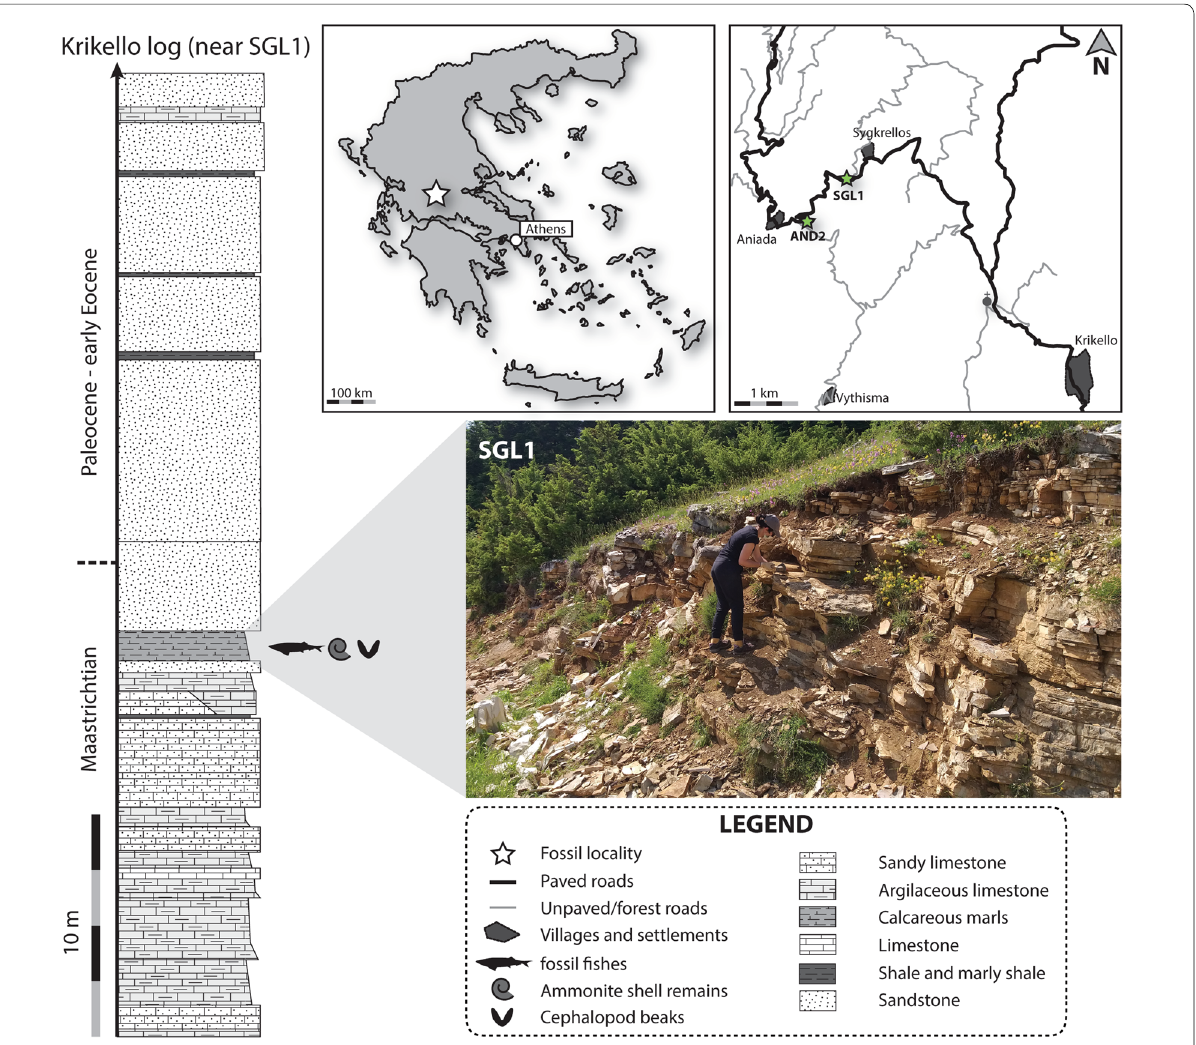
Fig. 1 Location and geological information for the sampling sites SGL1 in Eurytania, continental Greece. AND2 corresponds to the same stratigraphic horizon as SGL1. Stratigraphic log sensu Koch and Nikolaus (1969), with the Cretaceous–Paleogene boundary arbitrarily moved higher, to be contained within the lower flysch deposits sensu Fleury